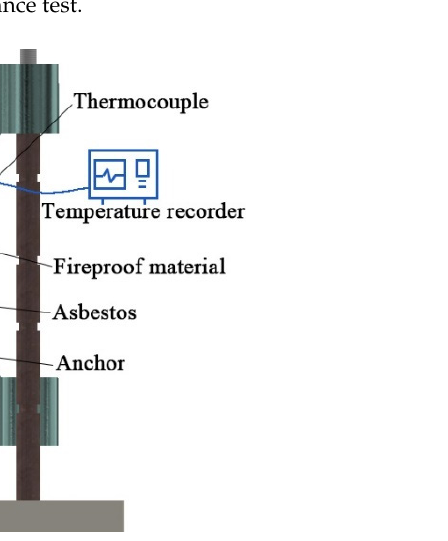
Figure 10. Test device of fire resistance test.